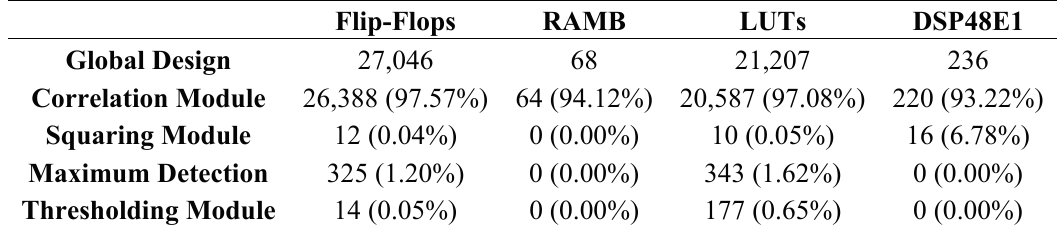
Table 2. Detailed resource consumption for the main modules of the design in a Xilinx XC7K325T FPGA.